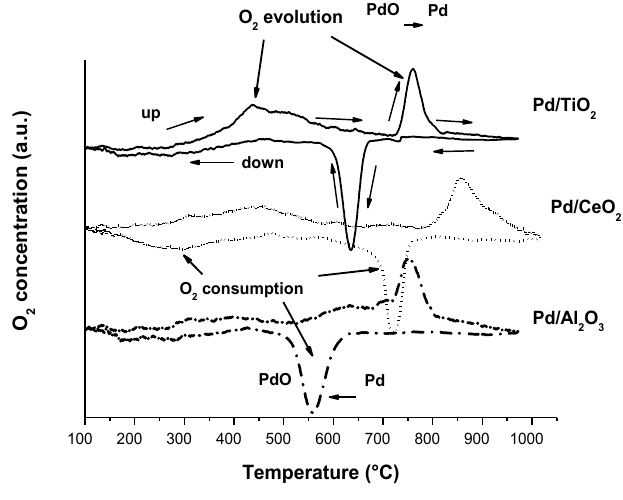
Figure 3. TPO profiles of Pd-supported